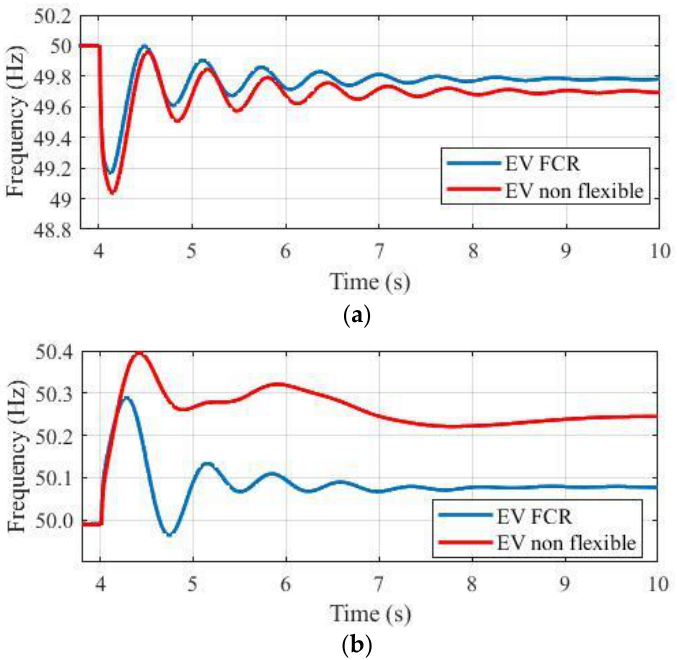
Figure 5. Contribution of EV charging in ( a ) underfrequency and ( b ) overfrequency